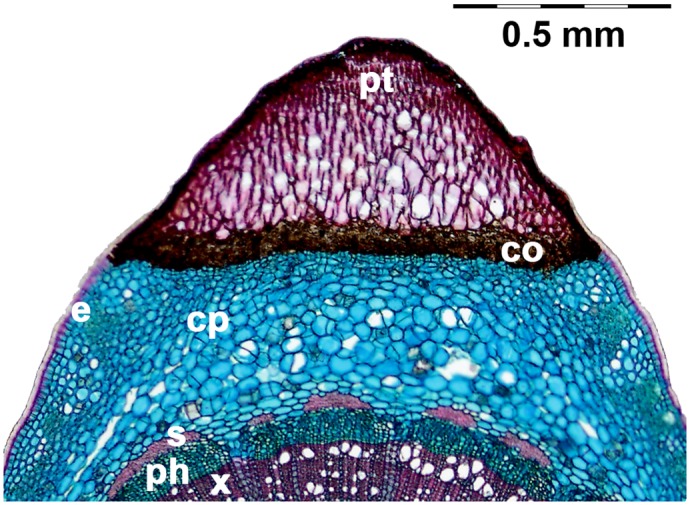
Transverse section of a Rosa arvensis ‘Splendens‘ stem with prickle (type I).The section is stained with FCA. x: xylem, ph: phloem, s: sclerenchyma, cp: cortical parenchyma, e: epidermis, co: cork, pt: lignified prickle tissue.